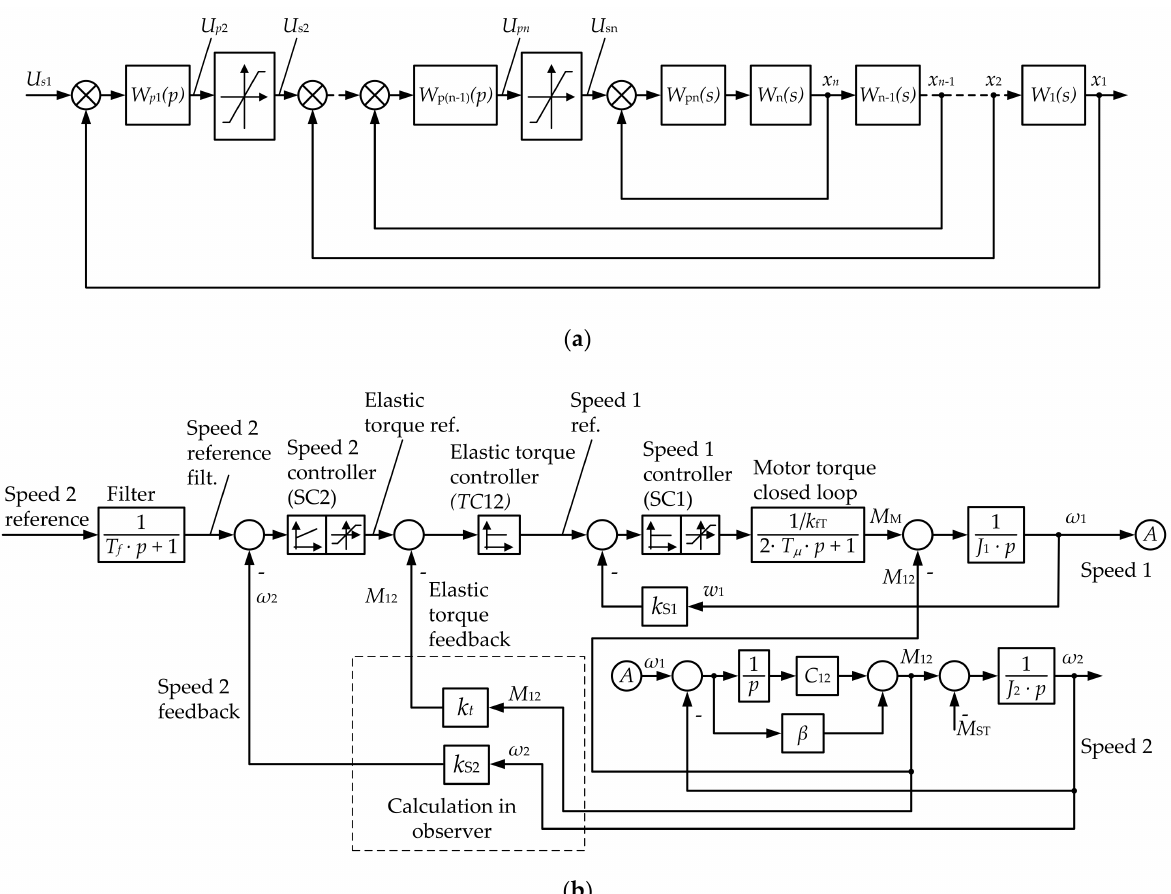
Figure 9. Generalized structure of the system with limited controller output signals ( a ) and block diagram of the developed three-loop speed ACS for the second mass ( b